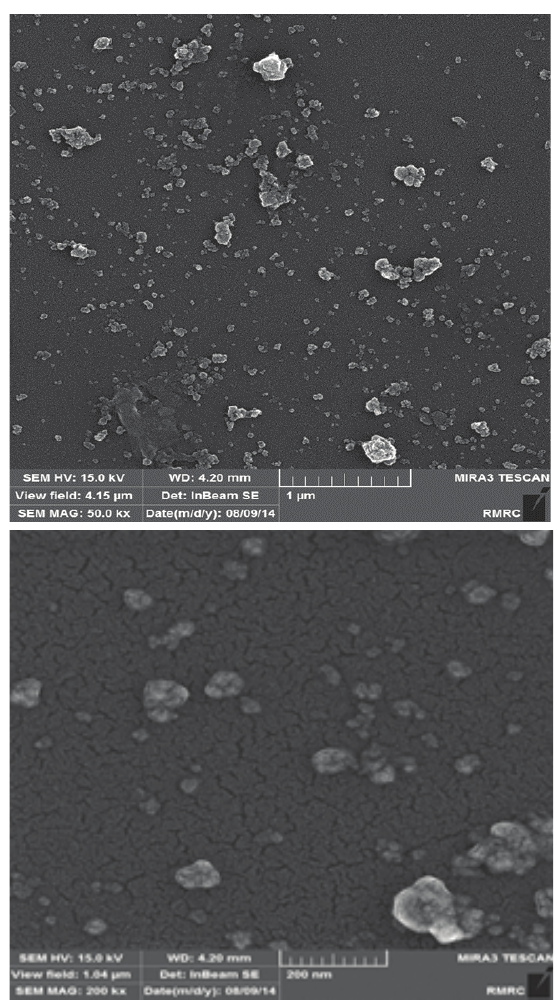
Fig. 7. SEM images of the prepared magnetite nanoparticles by the solvothermal method for 24 h at